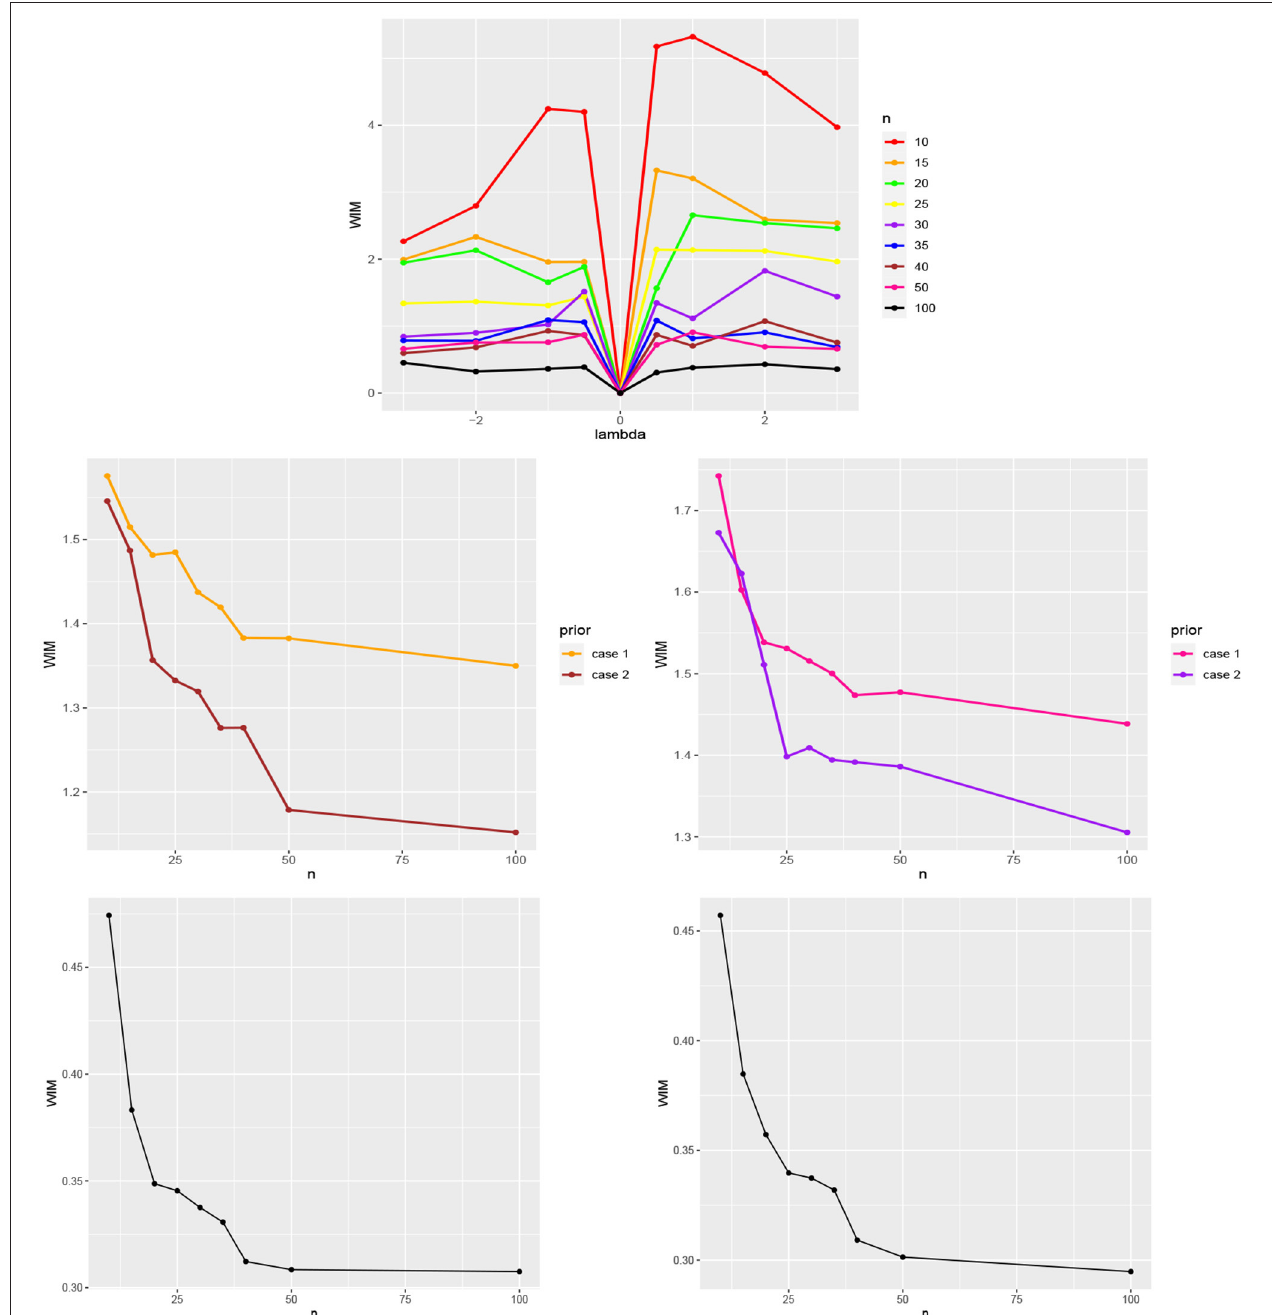
FIGURE 1 | (Top) WIM values for comparing the normal and skew-normal distributions as priors for the skewness parameter γ for different values of λ and n . (Middle) the Wasserstein distance between the posteriors π 1 and π 2 (case 1) and also π 1 and π 3 (case 2) for µ (right) and different values of n . (Bottom) the Wasserstein distance between the posteriors π 2 and π 3 for µ and different values of n . denoted by π 1 ( (cid:127) Algorithm 1 for n The Wasserstein distances were calculated between them with the transport package and Monte Carlo method with 1, 000 repetitions.